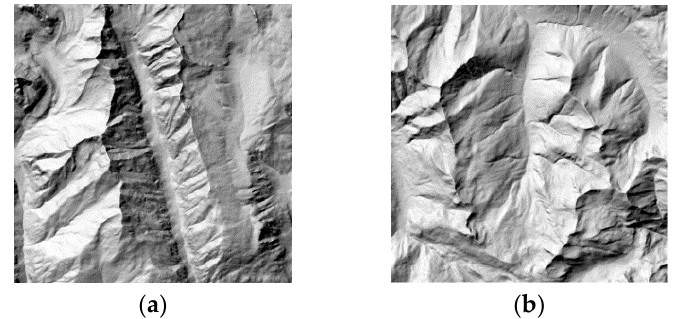
Figure 3. Standard hillshading with NW illumination of sample areas with: ( a ) U-shaped valley; ( b ) V-shaped valley.